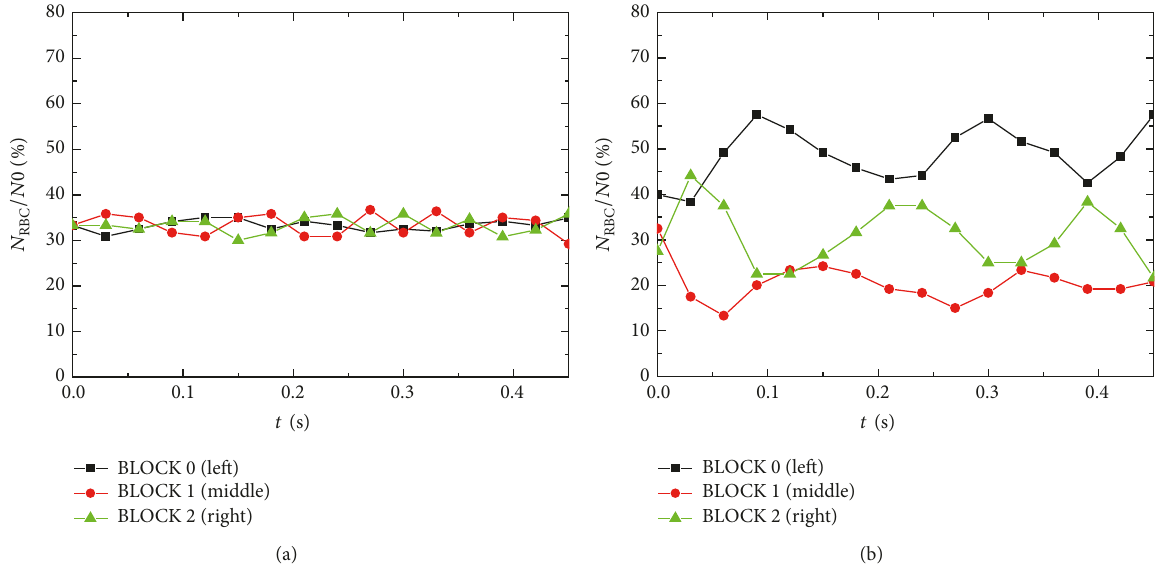
Figure 7: Comparison of RBC numbers in each computational block: (a) straight tube and (b) confined tube.